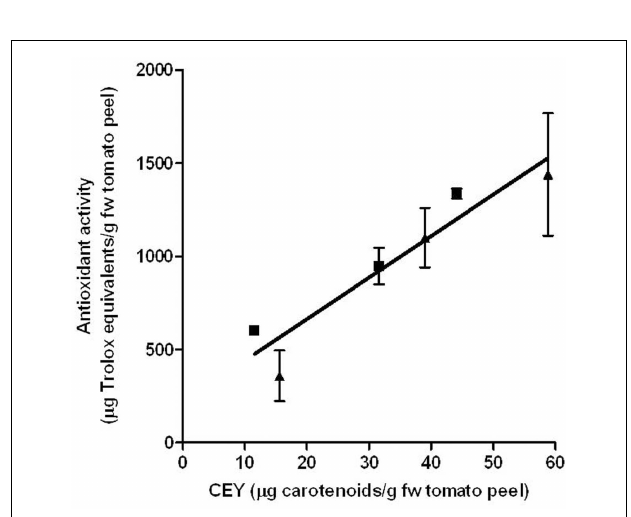
FIGURE 7 | Relationship between the carotenoid extraction yield (CEY) and antioxidant capacity of the extracts obtained from control ( (cid:4) ) and (cid:78) PEF-treated ( ) tomato peels .The error bars represent